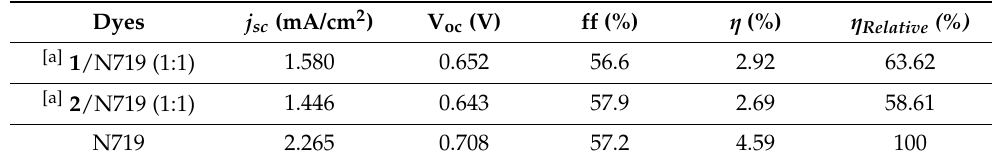
Table 4. J - V performance of DSSCs based on photoelectrodes of N719 co-sensitized with 1 and 2 .